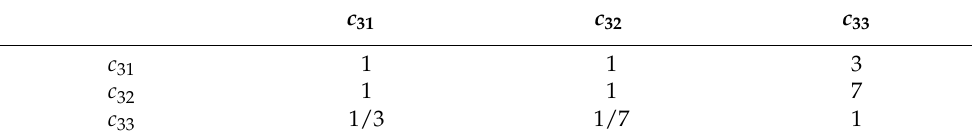
Table 7. Matrix for pairwise comparison of the sub-criteria of the usage condition.